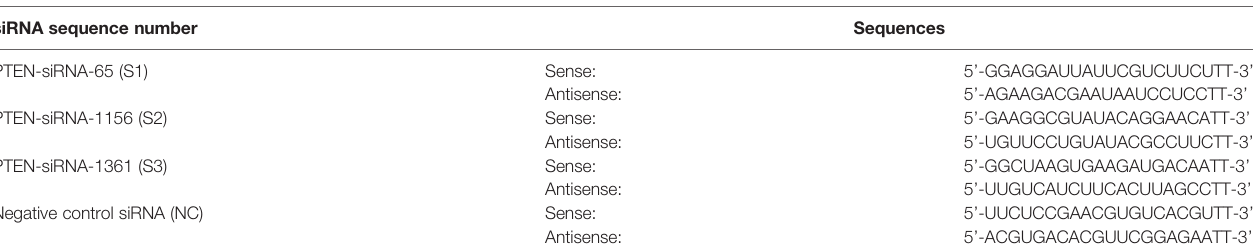
TABLE 1 | PTEN-siRNA